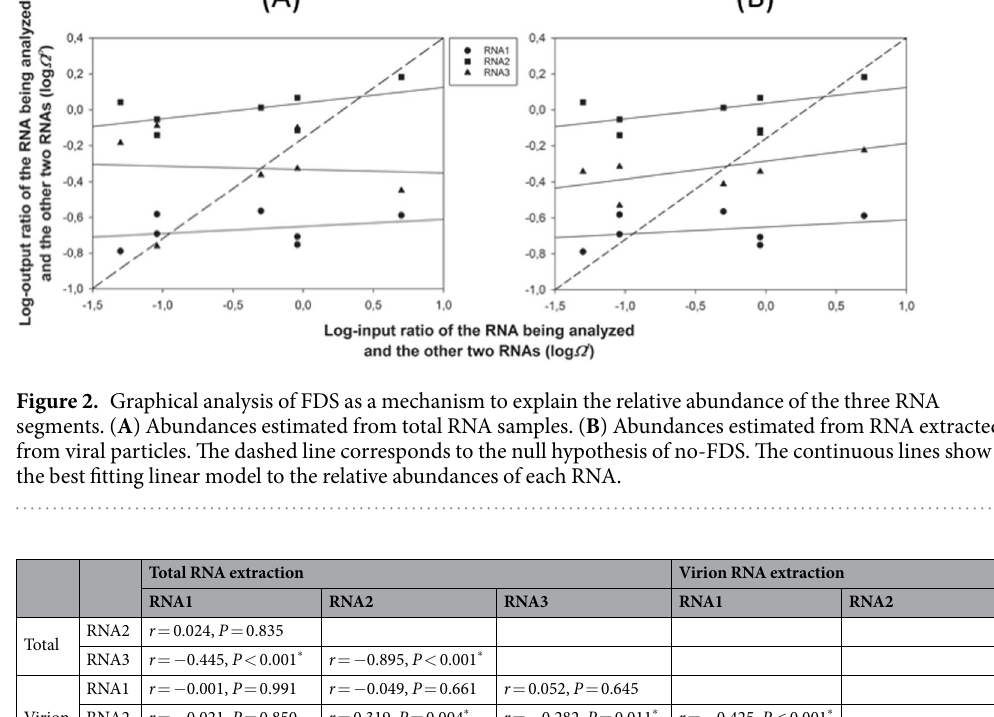
Table 2. Results from the partial correlation analyses among abundances of different RNA segments. All tests have 79 df . Asterisks indicate cases significant after the Holm-Bonferroni correction of multiple tests of the same null